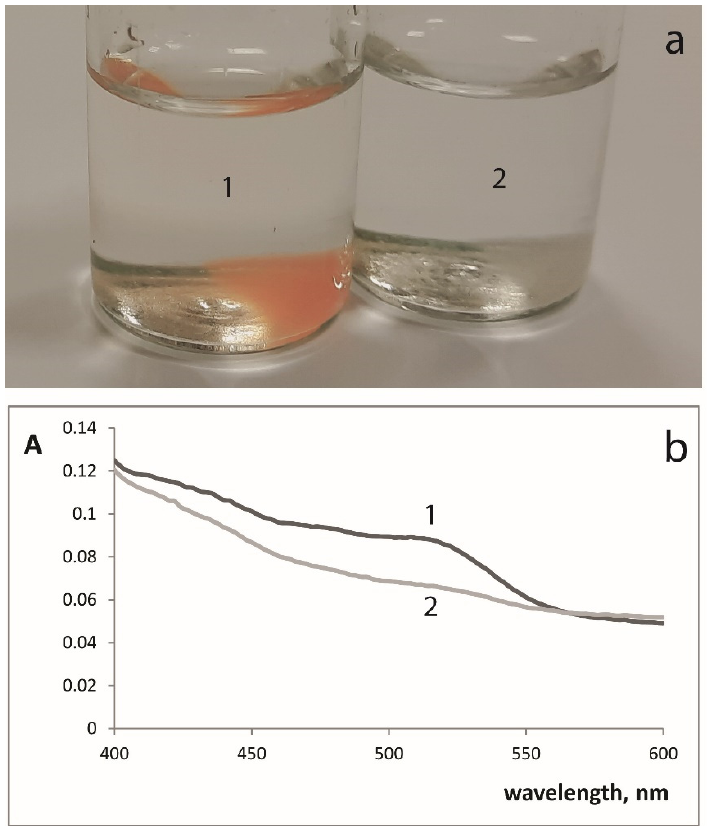
Figure 2. Interaction of SiFe xerogel with 0.075 M 1,10-phenanthroline solution in the presence of 5.0 × 10 − 5 M catechol (1) or in the absence of catechol (2). ( a ) coloration of SiFe xerogel, ( b ) spectra of SiFe xerogel.